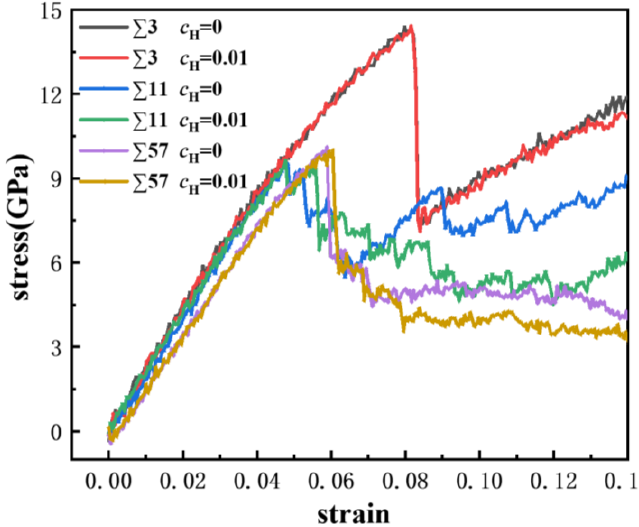
Figure 8. Comparison of strain-stress curves in di ff erent GBs at atomic hydrogen concentrations of 0 and